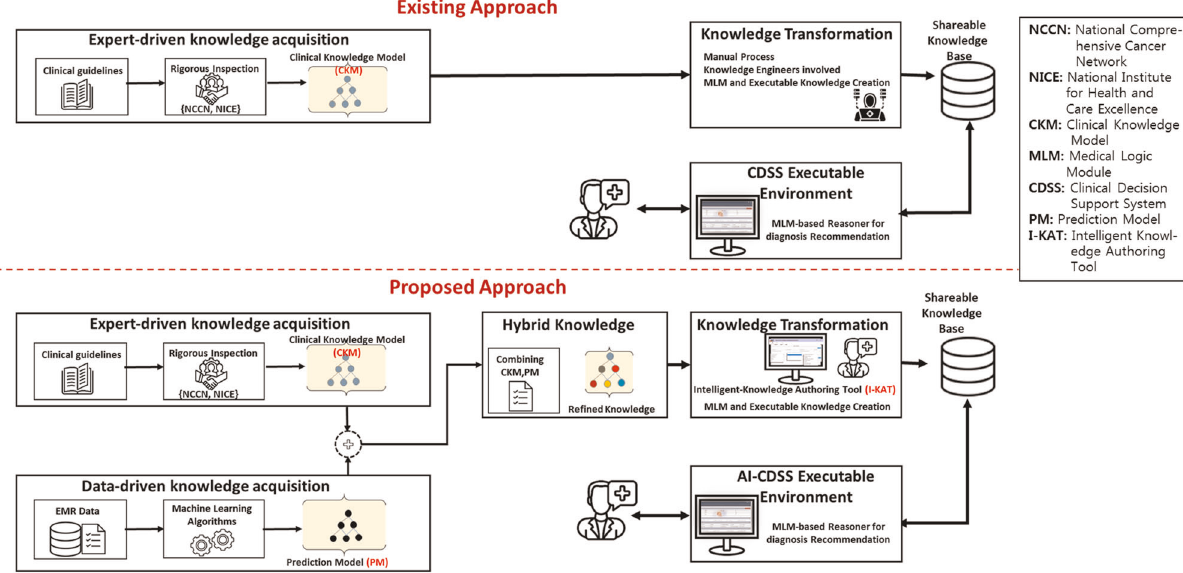
Fig. 1 Comparison of existing CDSSs and our proposed arti fi cial intelligence-CDSS. CDSS Clinical Decision Support System, CKM clinical knowledge model, I-KAT Intelligent Knowledge Authoring Tool, NCCN National Comprehensive Cancer Network, NICE National Institute for Health and Care Excellence, PM prediction path into R-CKM increases the coverage of patient cases to generate right recommendations and increase the accuracy. Validation of AI-CDSS